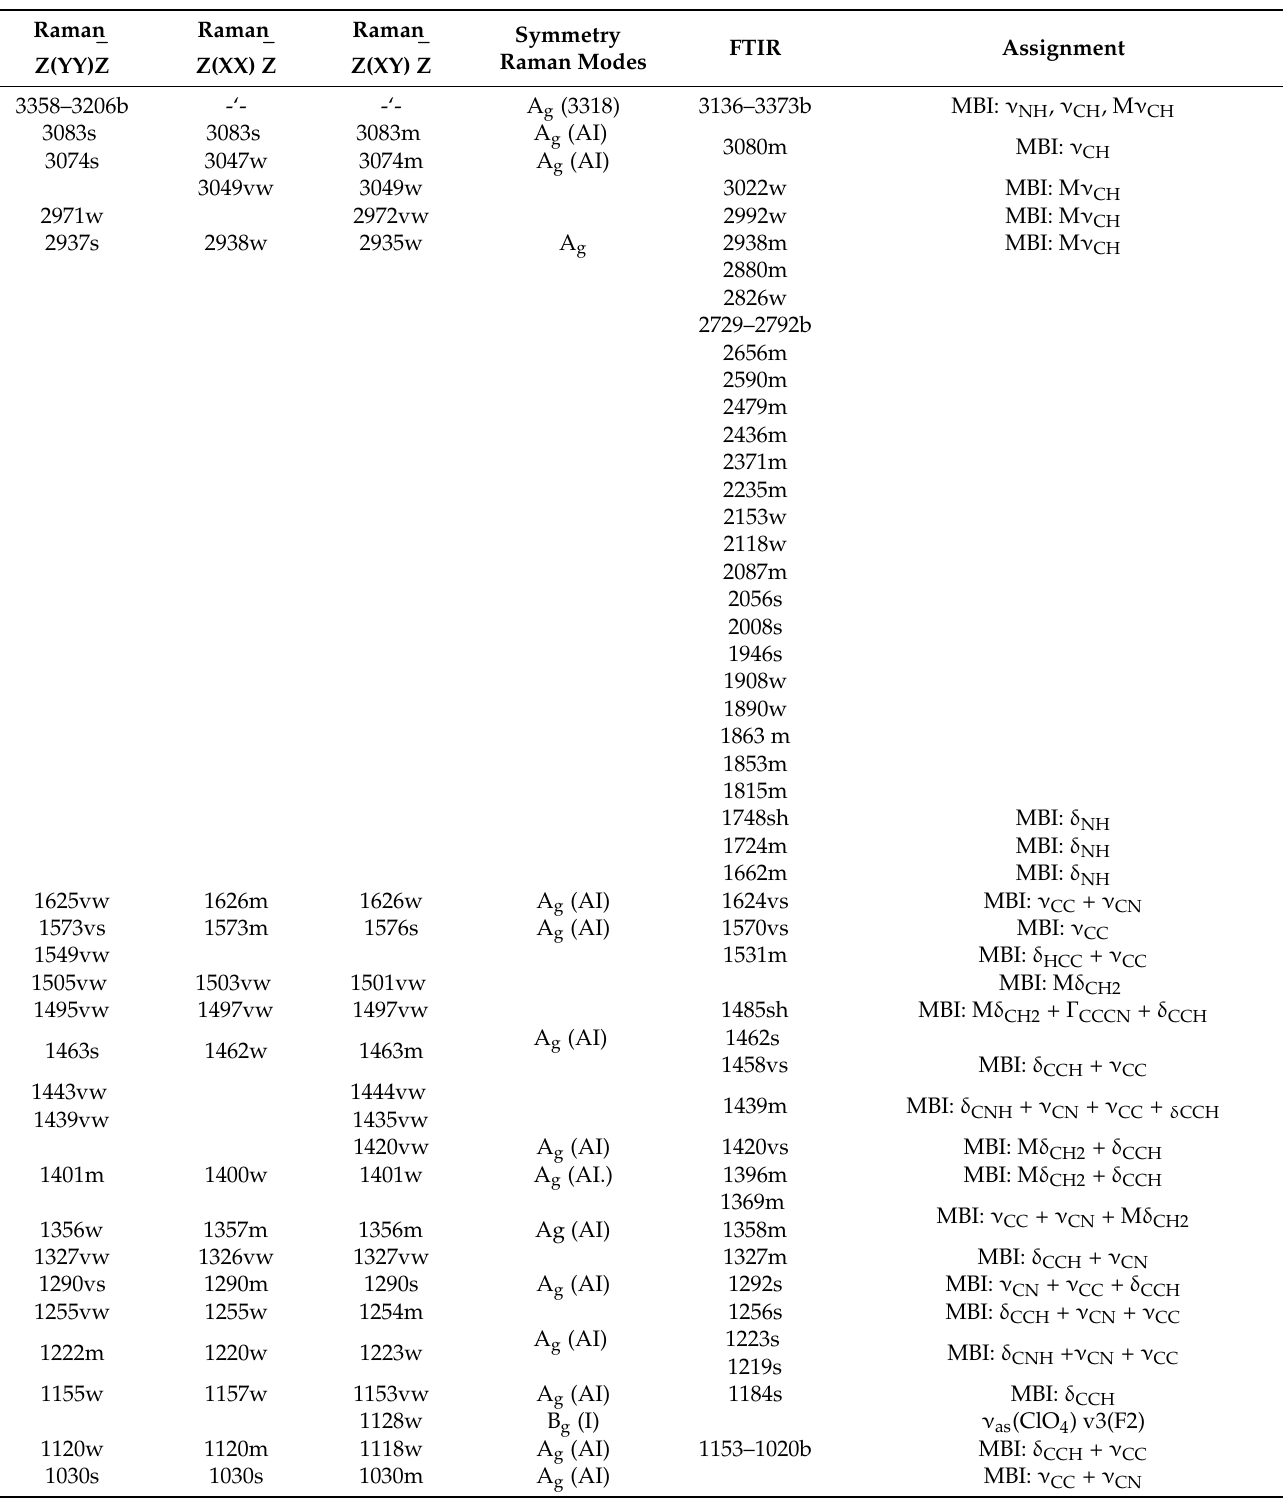
Table 4. Raman shifts and FTIR absorption lines (cm − 1 ) observed in MBI-perchlorate. Last column shows interpretation of the FTIR lines according to MBI assignment [60]. Abbreviations: vs—very strong, s—strong, m—medium, w—weak, b—broad, Γ —out-of-plane bending, δ —in-plane